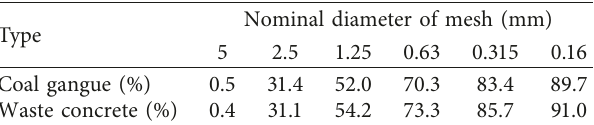
Figure 2: Coal gangue and wasted concrete fine aggregate. (a) Coal gangue. (b) Wasted concrete. Table 1: Cumulative residuals of the coal gangue and wasted concrete fine